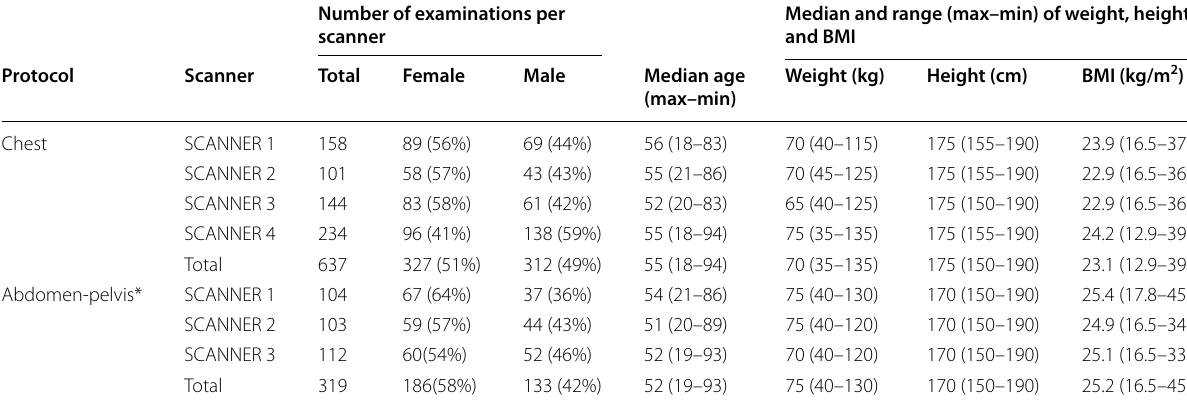
* Scanner 4 was used as emergency dedicated equipment and during the COVID’s pandemic period there wasn’t significate sample for abdomen-pelvis